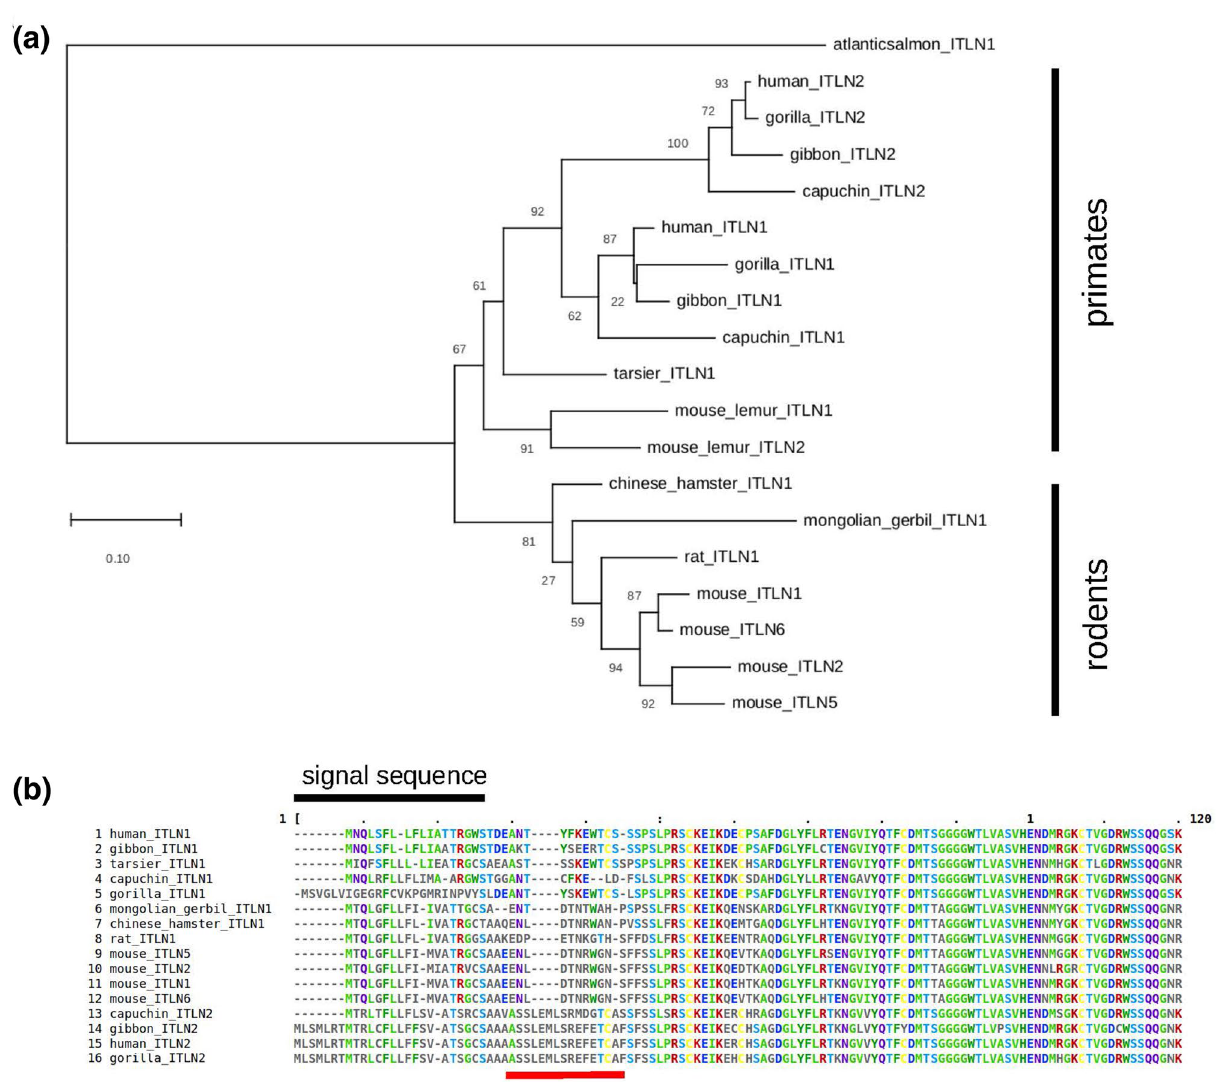
Figure 1. Intelectin genes in rodents and primates. (a) A phylogenetic tree based on amino acid sequences is drawn to scale, with branch lengths measured in the number of substitutions per site. Numbers at each node indicate bootstrap support for that node. (b) Amino acid sequence alignment of the N-terminal region of